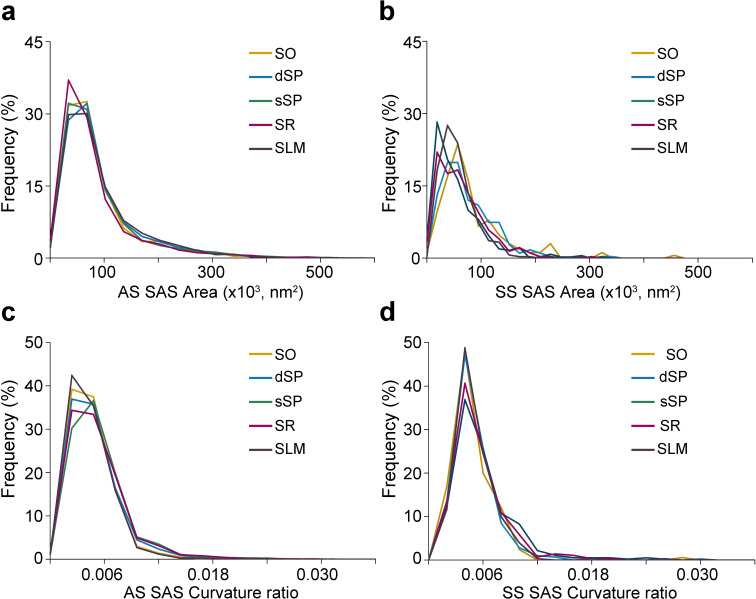
Frequency distribution histograms of the synaptic apposition surface (SAS) area and curvature in CA1.(a,b) Frequency distribution histograms of SAS area in all layers of CA1 for asymmetric synapses (AS) (a) and symmetric synapses (SS) (b). Note there is a clear overlap in the frequency distribution among layers both for AS and SS. (c,d) Frequency distribution histograms of SAS curvature ratio in every CA1 layer for AS (c) and SS (d). Note there is a clear overlap in the frequency distribution among layers both for AS and SS. All histograms show a positive skewness with a higher frequency of smaller values than bigger ones. SO: stratum oriens; dSP: deep stratum pyramidale; sSP: superficial stratum pyramidale; SR: stratum radiatum; SLM: stratum lacunosum-moleculare.